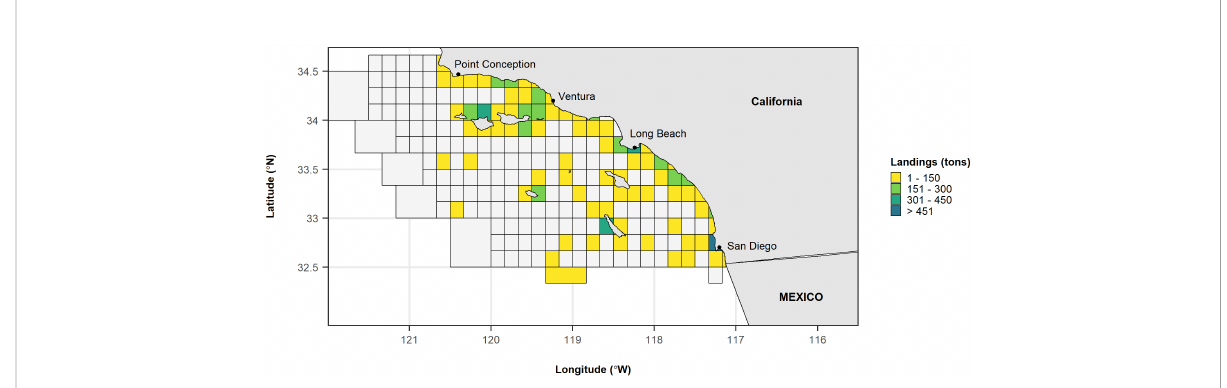
FIGURE 1 Map of total California commercial spiny lobster fi shery landings (tons) by fi shing block from 2000 to 2019 fi shing seasons (CDFW Marine Landings Database System, MLDS). Fishing blocks with less than 15 entries were excluded.